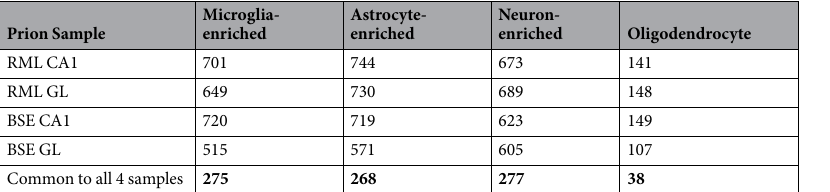
Table 1. Differentially expressed genes enriched in the major brain